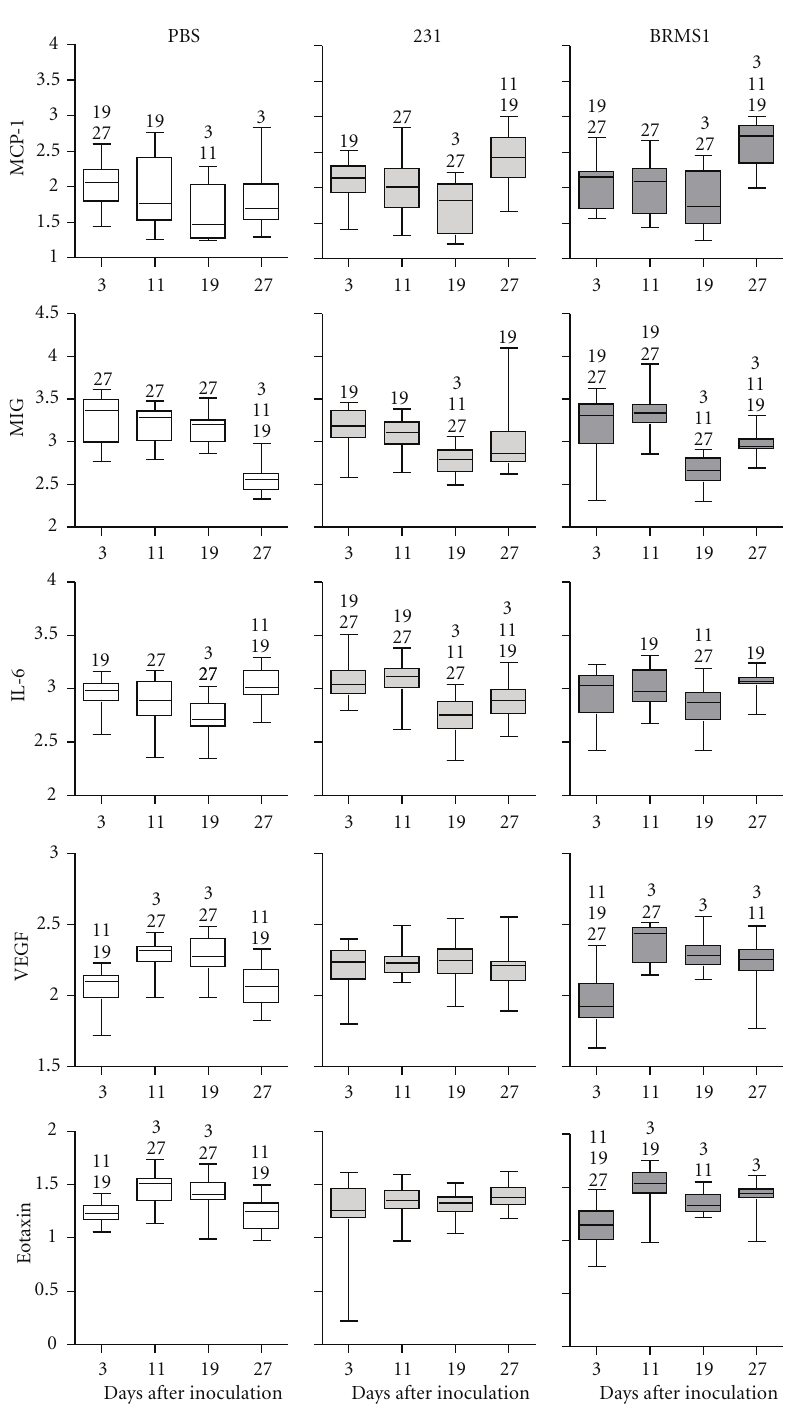
Figure 4: Changes in bone cytokine levels over time. Cytokine values were obtained as described in Section 2. Results were log 10 transformed for analysis and graphic comparison of each injection group over the 4 points of the study. Each box plot graph represents the change in a particular cytokine level for one injection group over time. The box represents the 75–25% range of values; the horizontal line within the box denotes the mean. Bars above and below the box mark the maximum and minimum values. Numbers above each box denote a significant di ff erence ( P < 0 . 05) between time points. n =